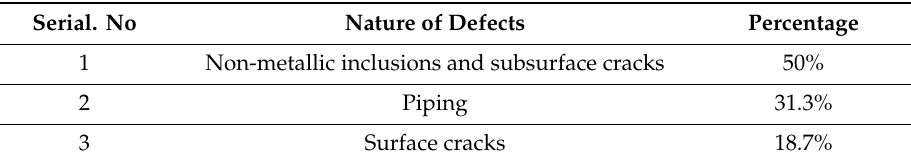
Table 4. Past data of shaft rejection based on ultrasonic testing